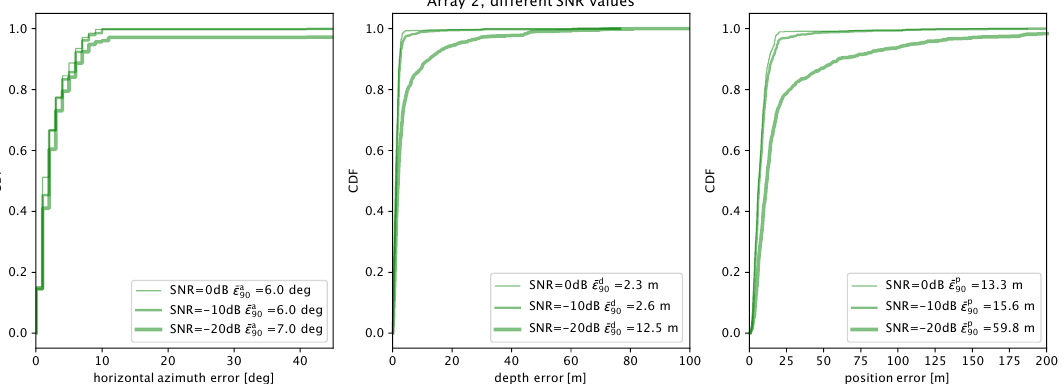
Figure 12. Localization error results for array 2 at different SNRs of 0, − 10 and − 20 dB: azimuthal angle error ( left ); depth error ( center ); and total location error ( right